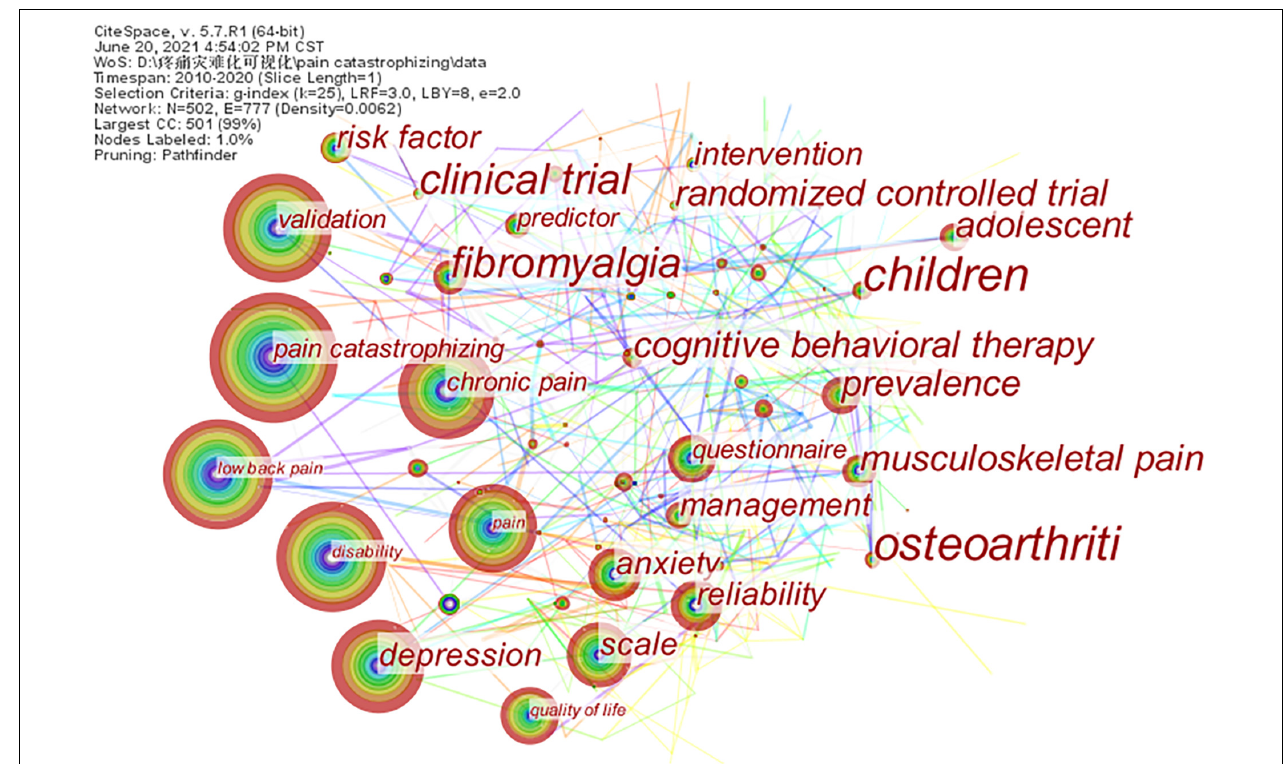
FIGURE 6 | A keyword co-occurrence map of pain catastrophizing research from 2010 to